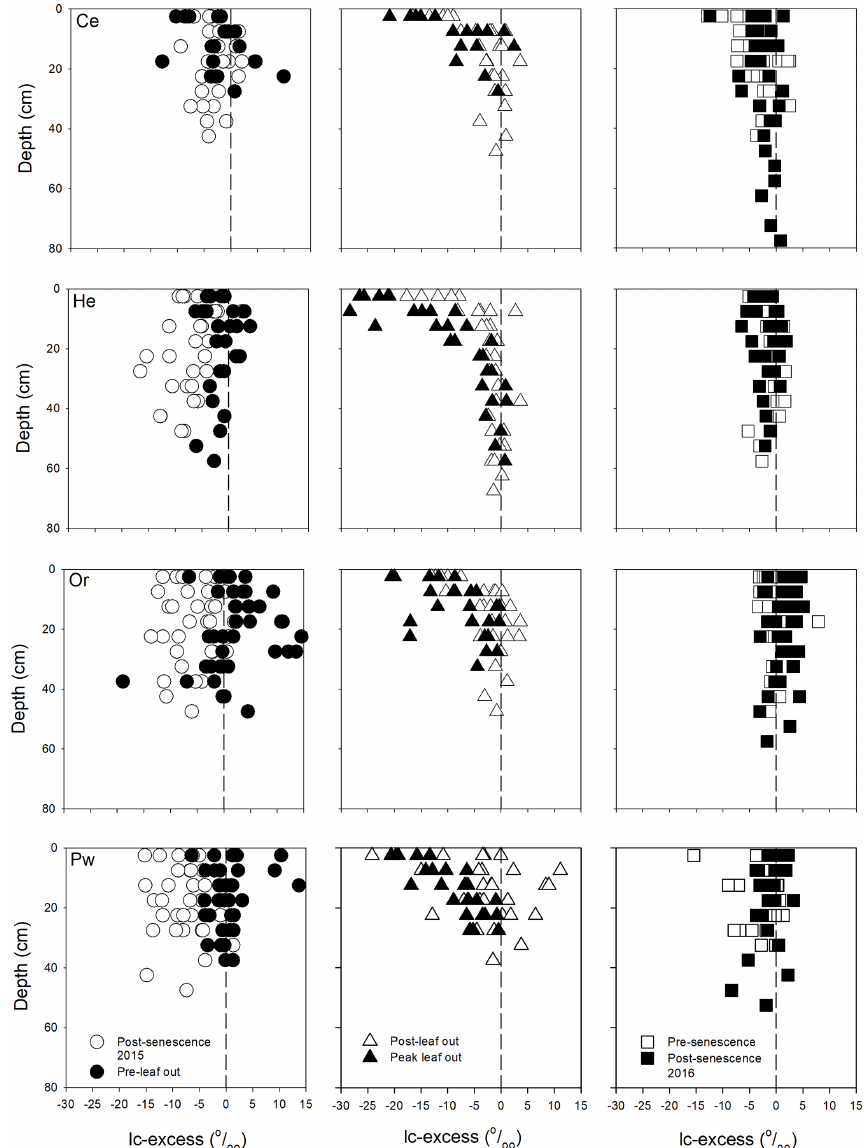
Figure 3. Bulk soil water lc-excess at different depths for the sampling periods for Ce (first row), He (second row), Or (third row) and Pw (fourth row). Vertical dashed line indicates a lc-excess of